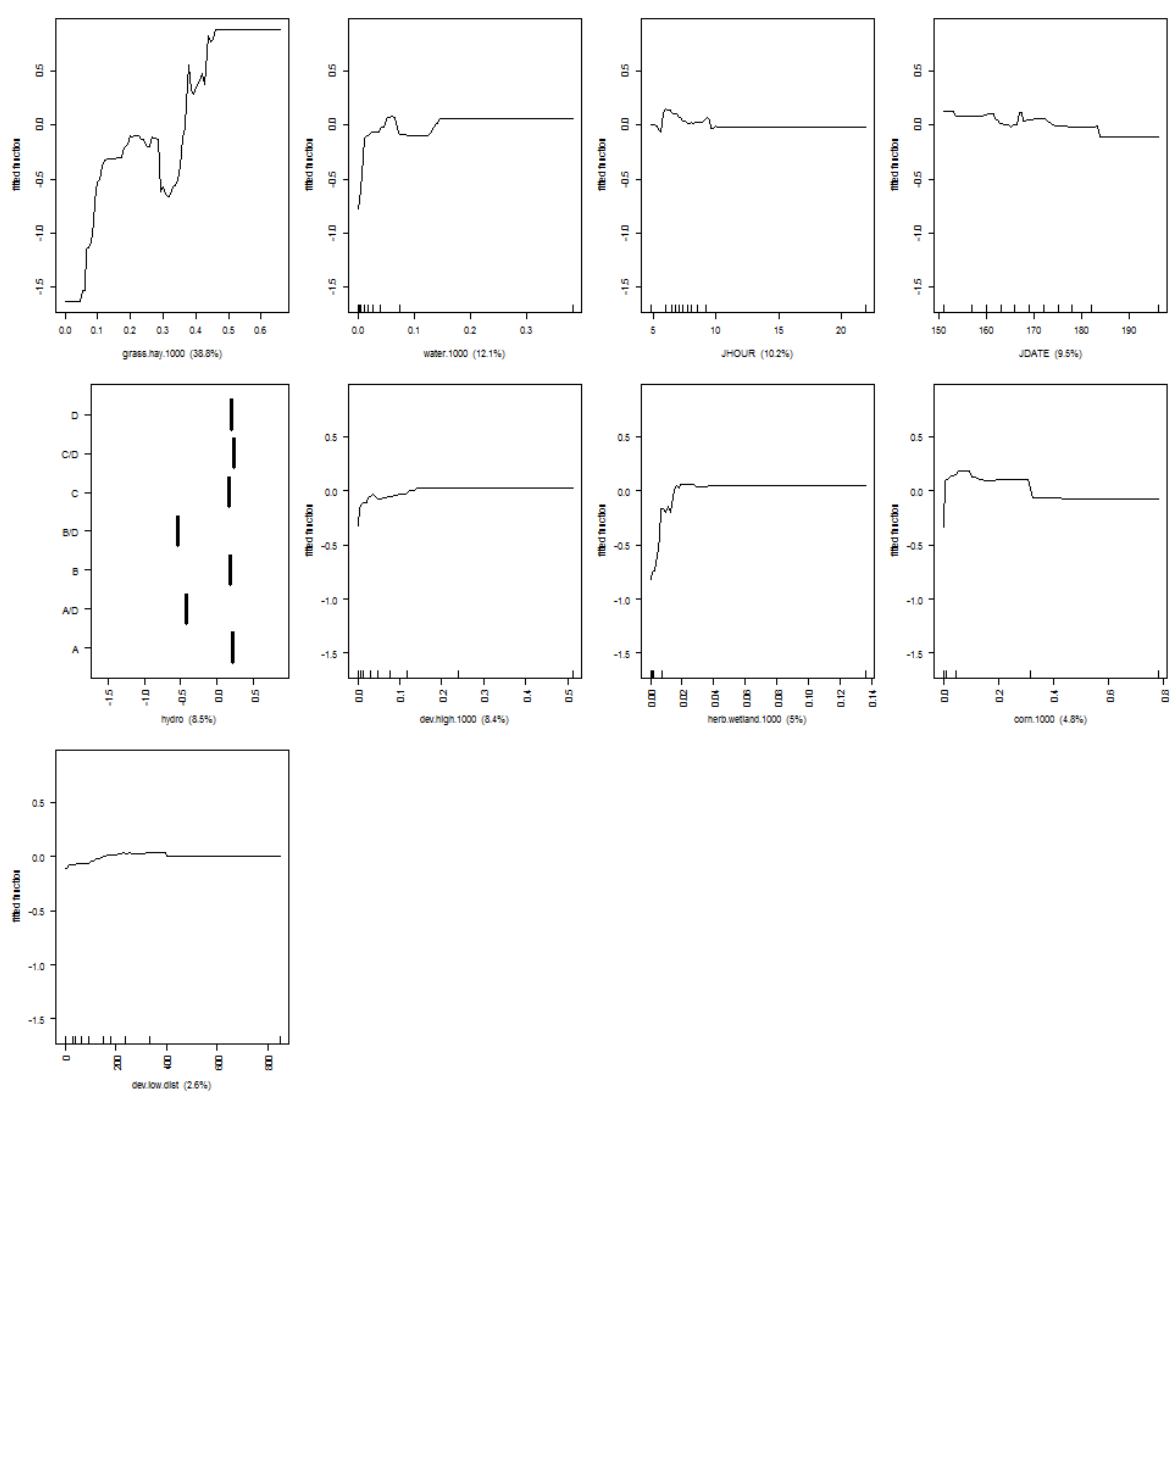
Figure A1.4e. Response curves for Sedge